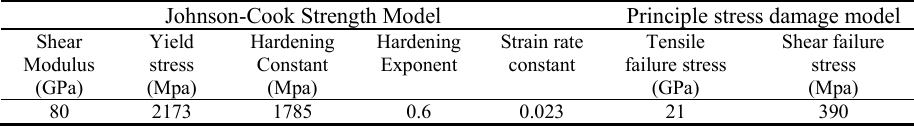
Table 1 Material models and parameters used in the numerical